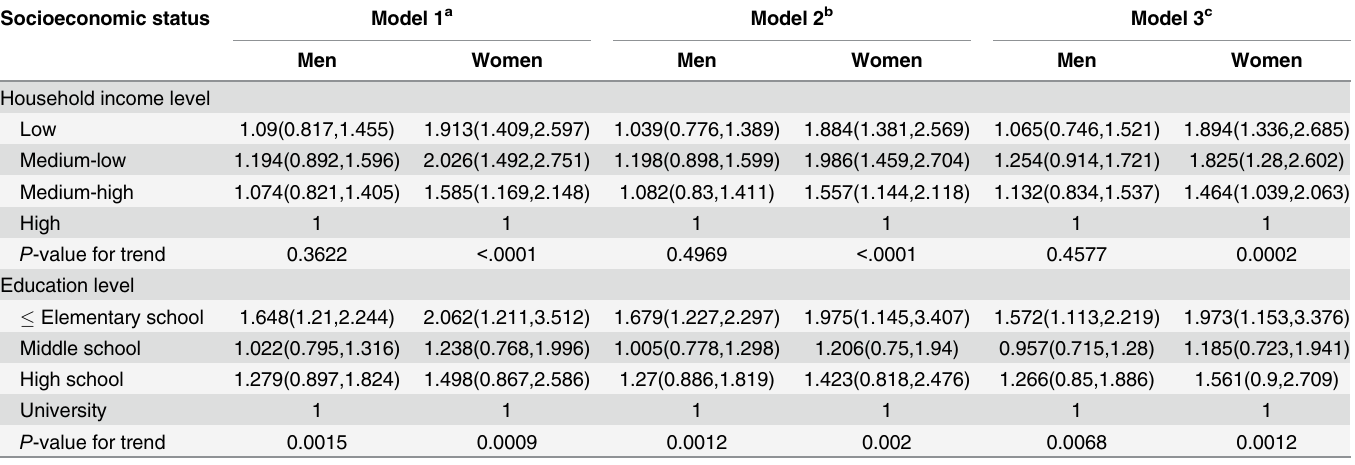
Table 3. Odds ratios (95% confidence intervals) of blepharoptosis by socioeconomic status among men and women.